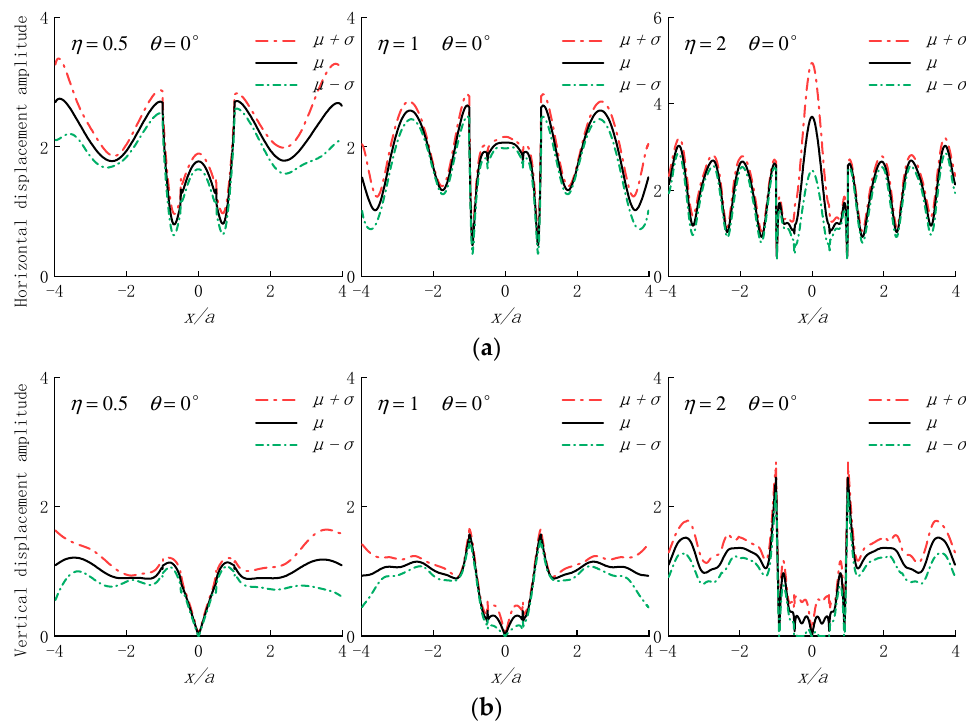
Figure 5. Effect of permeability coefficient randomness at different incident angles on the surface displacement amplitude in sedimentary river valleys (𝜃 = 0°) . ( a ) Horizontal displacement; ( b ) Vertical displacement.